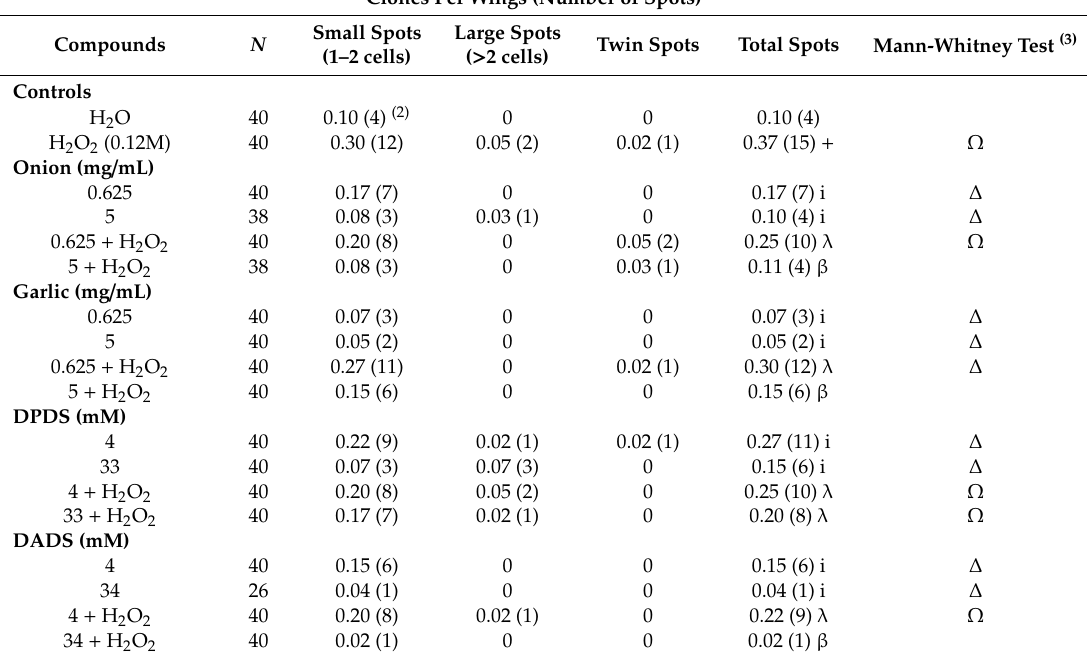
Table 1. Genotoxicity and antigenotoxicity results obtained in the SMART test when flies were fed with di ff erent concentrations of onions, garlic, and organosulfur DPDS and DADS in single and combined